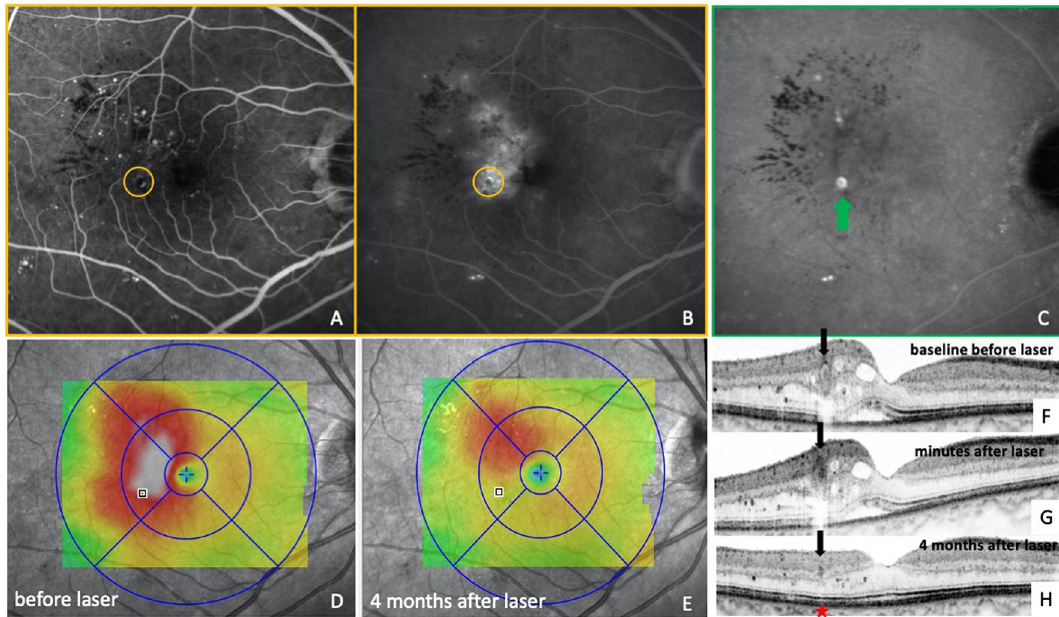
Figure 5. Multimodal imaging of the right eye of a patient with treatment naive diabetic macular edema. Early-phase fluorescein angiography (FA) shows numerous microaneurysms predominantely in the temporal macula ( A ). Late-phase FA reveals an area of diffuse leakage in this area. In contrast, late-phase indocyanine green angiography (ICGA) (≥ 10 min) reveals one bright hyperreflective spot in and around this area. The OCT thickness map revealed extensive diabetic macular edema involving the fovea ( D ). Therefore the patient was scheduled for ICGA-guided focal laser therapy. Note that the OCT single scan leads right through the center of the TC, which shows a hyporeflective lumen compared to the surrounding vessel wall ( F ). Minutes after several laser burst have been applied on the surface on the TC, a darkening of its lumen can be observed with OCT ( G ). Consequently, the TC fully resolved as early as 4 months after the treatment without damage to the underlying photoreceptors ( H , red asterisk), together with most of the intraretinal fluid and only little remaining parafoveal retinal swelling ( E